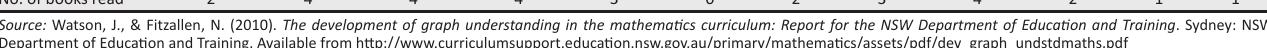
TABLE 1: The number of books read by 12 students. Name of